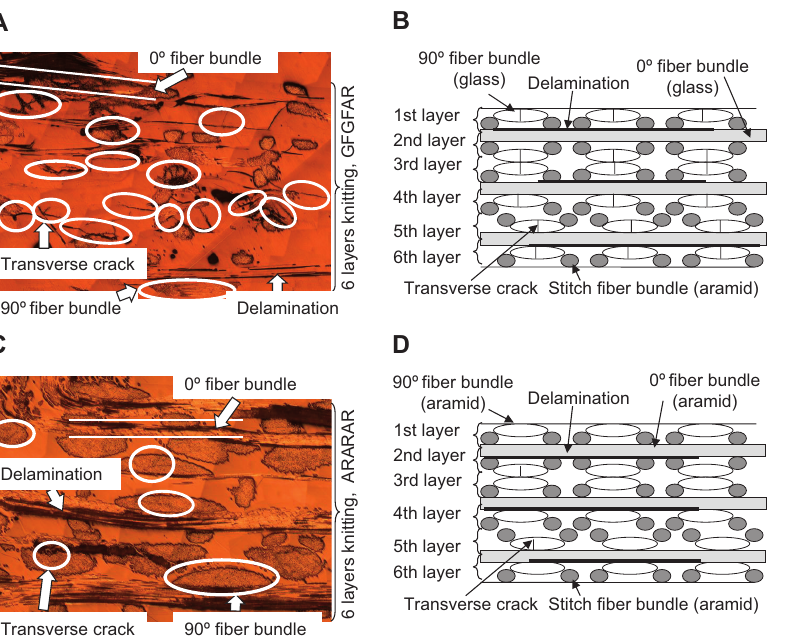
Figure 9 Enlarged view of cross-sectional photographs of the specimens after the three-point bending impact test and schematic draw- ings: (A, B) GF-GF-AR and (C, D) AR-AR-AR; transverse cracks are indicated by